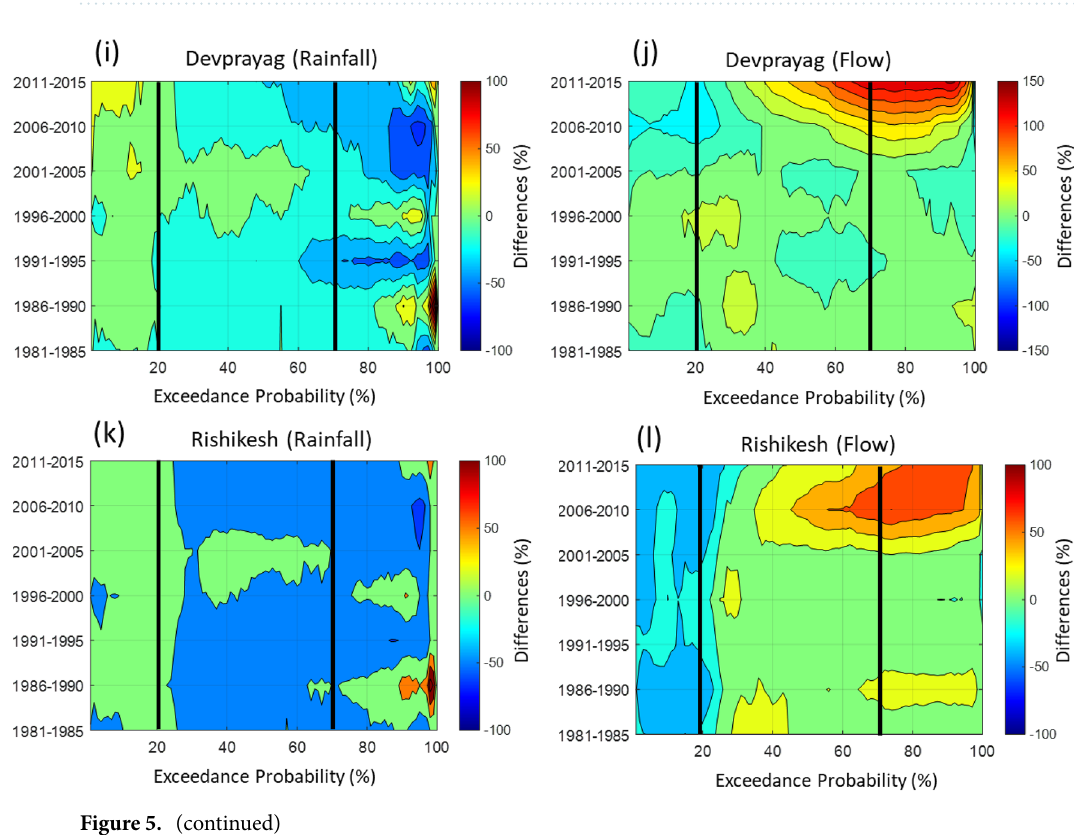
Figure 5. 5-yearly differences in rainfall and flow duration curves (FDCs) are plotted using 2d contour plot for each station. The high (20% <), moderate (20–70%) and low (> 70%) flows are divided by black vertical lines. (a) The Uttarkashi station shows 90% reduction in low rainfall. The high rainfall slightly increased (up to 10% since 1986). (b) The Uttarkashi station shows up to 90% reduction (1981–1985) in low flows. The high flows also decreased up to 30%. (c) The Tehri station shows a reduction of 100% in low rainfall throughout the period. There is no anomalous behaviour observed in low and moderate rainfall magnitudes after 2005 at Tehri. (d) The Tehri station shows a reduction of up to 50% in low flows until 1990. After 2000, the reduction in low flows up to 85% is also appeared here. The high flows increased by 50% after 2005. The moderate flows have been increased up to 80% after 2005. (e) The Joshimath station shows increasing high, low and moderate rainfall magnitudes after 1996. The high and low magnitude rainfalls are increased up to 30% and 50%, respectively. (f) The Joshimath station shows a reduction from 20 to 70% in low and moderate flows. The high flows increased by 20% from the reference condition. (g) The Rudraprayag station shows increasing high magnitude rainfall by 30% from 1996. The moderate rainfall magnitudes have also slightly increased post-1995. (h) The Rudraprayag station shows a 10–20% reduction in all flows until 1995. The high flows have been increased 20–40% after 1995. The high rainfall magnitudes have increased up to 10% at (i) Devprayag and (k) Rishikesh stations. However, the high rainfall magnitudes have increased steeply (up to 30%) after 2005 at Devprayag than Rishikesh. The low and moderate rainfall magnitudes have decreased from the reference period at both stations. However, the percentage reductions in low and moderate rainfall magnitudes are slightly higher for the Rishikesh (up to 50%) than Devprayag (20% to 30%). The major changes in low and moderate flows up to 80% and 40% appeared at (j) Devprayag and (l) Rishikesh after